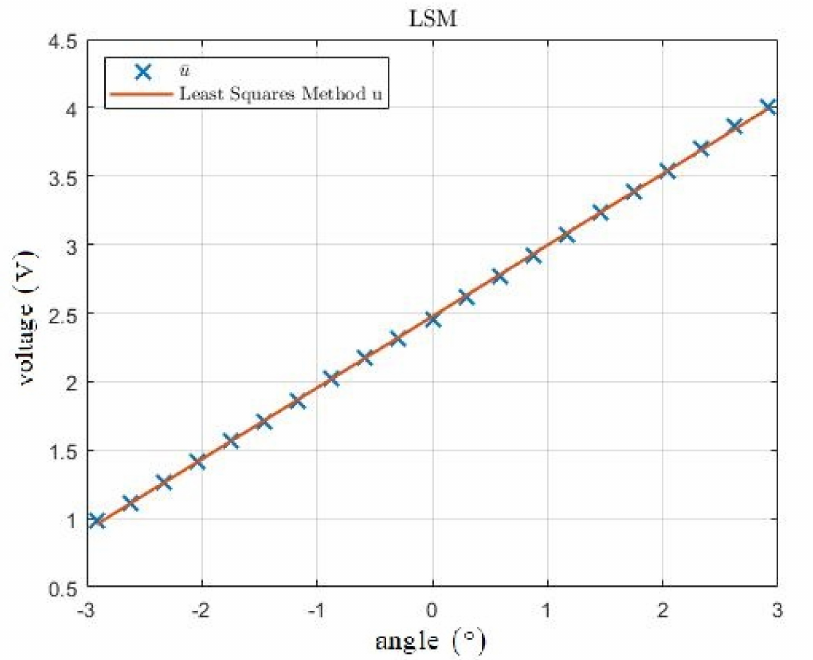
Figure 8. Comparison between means u of measured data (blue crosses) and LSM approximation (red line).